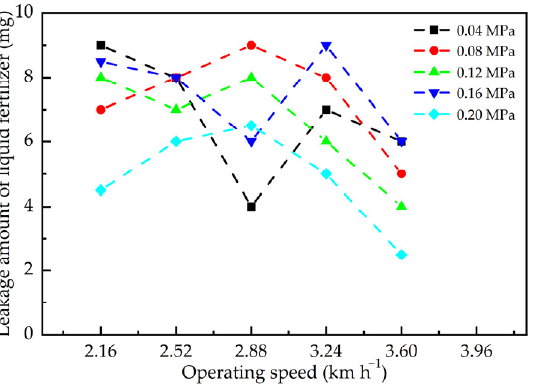
Figure 13. Leakage amount of fertilizer under the same pressure and different speeds. During the furrowing operation, the liquid fertilizer jet strikes the soil surface at a cer‑ tain inclination angle and loses part of its momentum, and this part of the energy is trans‑ ferred to the damaged soil surface in the form of action force [48], as shown in Figure 14. When the pressure at the outlet of the fertilizer spray tube is small, the liquid fertilizer is sprayed out and cannot destroy the soil surface due to the blocking effect of the water flow and the soil, and the liquid fertilizer remains in the water layer. As the pressure increases, part of the jet is shot into the soil and retained in it. Therefore, the analysis of the size of the outlet pressure of the fertilizer spray pipe and the critical ground‑breaking pressure is of guiding significance for the measurement of the leakage amount of fertilizer [49]. The